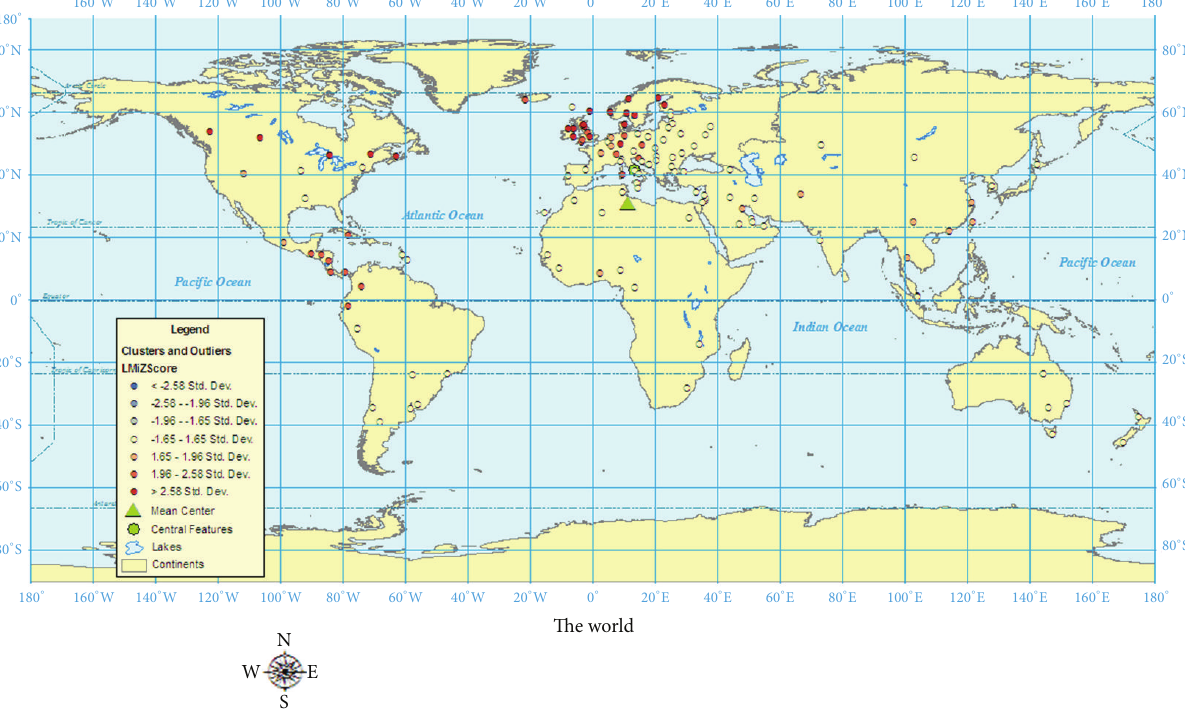
Figure 2: World map of MS prevalence analysis of clusters and outliers using 131